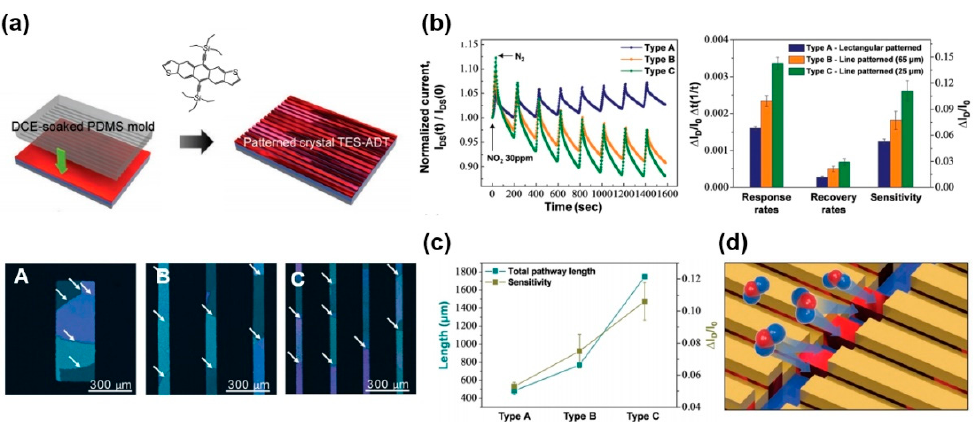
Figure 6. ( a ) Fabrication procedure of TES-ADT microstripes using a polydimethylsiloxane (PDMS) mold and the types of fabricated microstripes: ( A ) rectangular patterns of 200 µm width, ( B ) line pattern of 65 µm width, and ( C ) line patterns of 25 µm width. The white arrows indicate the grain boundary. ( b ) gas-sensing characteristics and summarized performance according to the types of microstripes, ( c ) comparison curve of the sensitivity versus pathway length (sum of grain boundary length and edge length), and ( d ) schematic showing gas diffusion in TES-ADT microstripes [83]. Copyright 2020 Wiley.